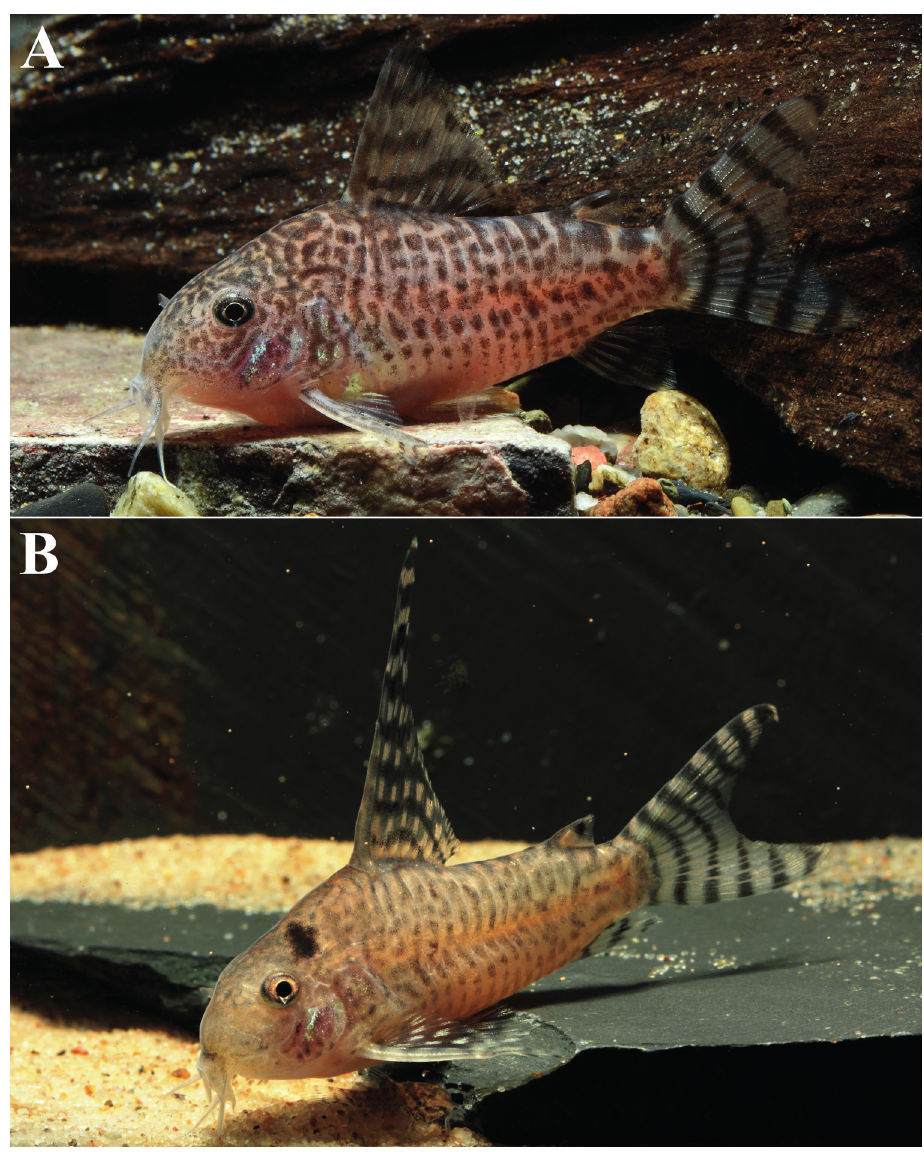
FIGURE 4 | Uncatalogued aquarium specimens of Corydoras thanatos photographed alive, showing general color pattern and morphology of ( A ) a female specimen, and ( B ) a dimorphic male specimen. Photos by Hans